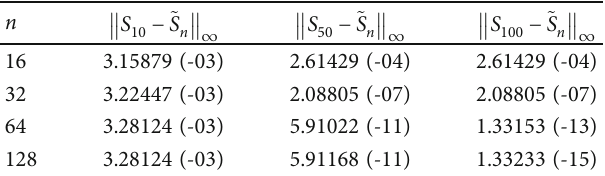
Table 10: Error norms between S ~ . S n n